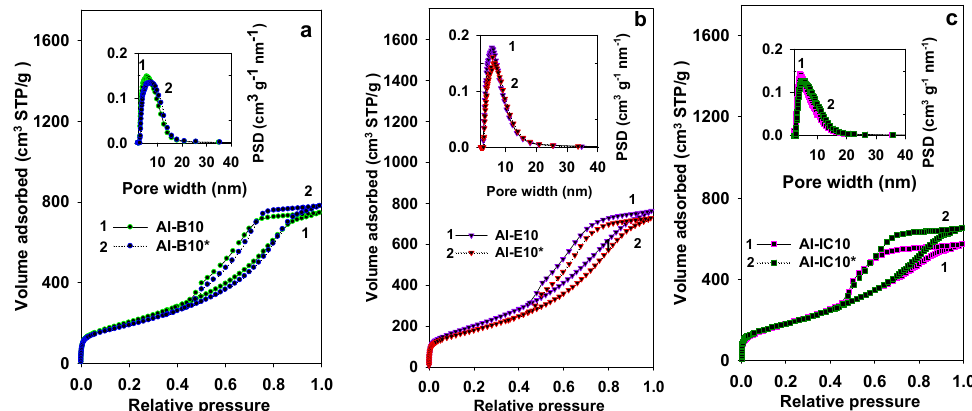
Table 1. Adsorption parameters obtained for the alumina–silica samples studied.